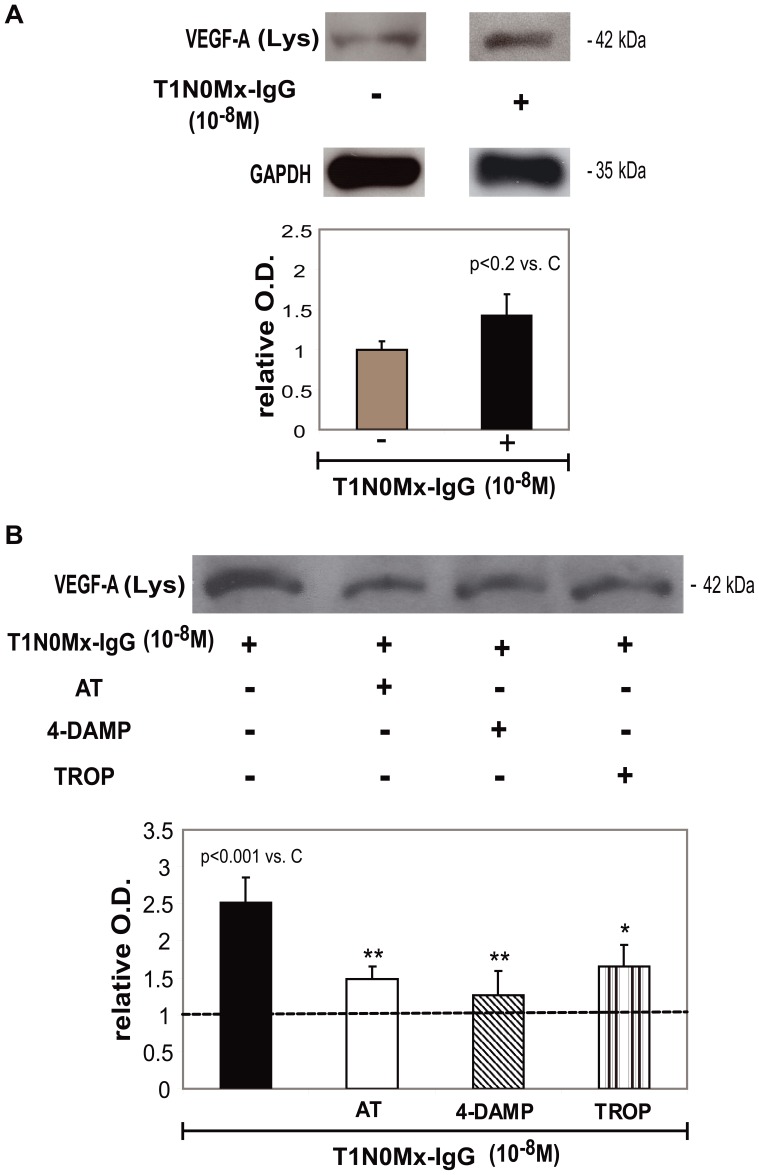
Effect of T1N0Mx-IgG on VEGF-A expression in MCF-7 cells.Western blot assays were performed in cell lysates (Lys) obtained from A) untreated MCF-7 cells or treated with IgG from breast cancer patients in stage I (T1N0Mx-IgG) (10−8 M) during 1 h in the absence or B) presence of 10−8 M atropine (AT) 4-diphenylacetoxi-N-methylpiperidine (4-DAMP), or tropicamide (TROP). Densitometric analysis of the bands is shown. Values were relativized to the expression of glyceraldehyde-3-phosphate dehydrogenase (GAPDH) and to the expression of VEGF-A in MCF-7 cells without treatment considered as 1, and is represented by a dotted line. Molecular weights are indicated on the right. Values are mean±S.E.M. of three experiments. *p<0.01; **p<0.001 vs.T1N0Mx-IgG.